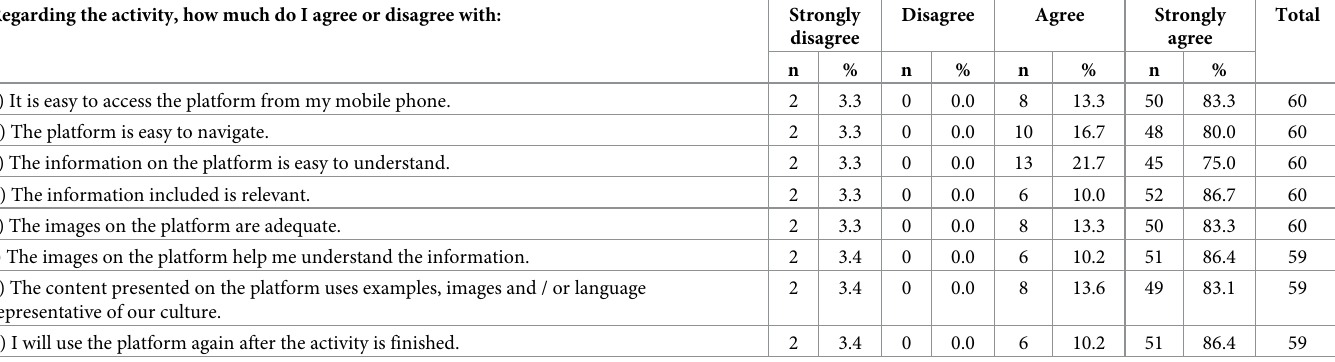
Table 3. Participants in the evaluation of Mi PROTECT report-back prototype (N = 61). Regarding the activity, how much do I agree or disagree